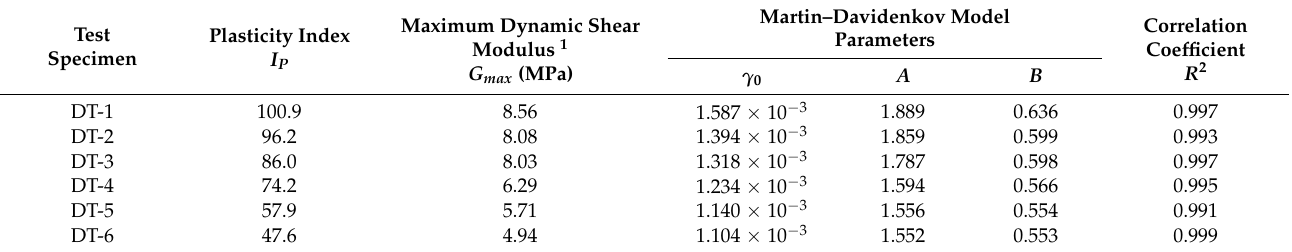
Figure 11. Relationship between cyclic shear strain and normalized dynamic shear modulus curves for the mineral composition of artificial marine clays. Table 6. The parameters result of the Martin–Davidenkov model of artificial marine